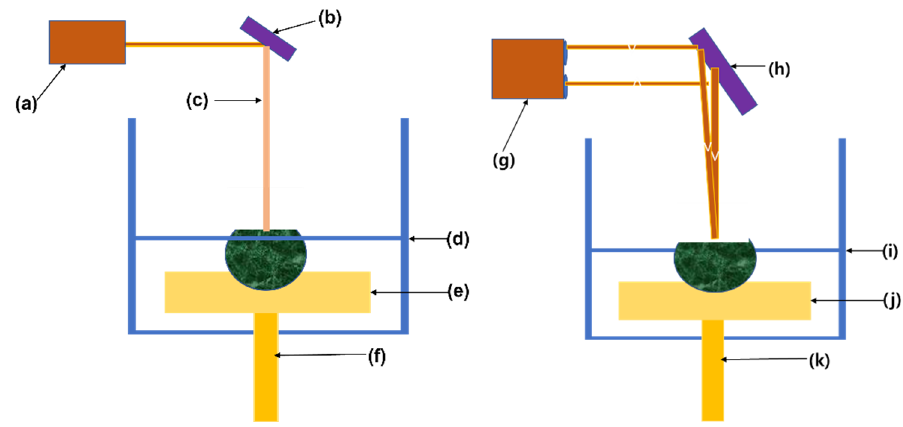
Figure 2. Scheme of stereolithography (SLA) and digital light processing (DLP). ( A ) SLA: (a) Laser source; (b) Scanning mirror; (c) Laser beam; (d) Liquid resin surface; (e) Platform (f) Piston, and ( B ) DLP: (g) Projector; (h) Scanning mirror; (i) Liquid resin surface; (j) Platform; (k) Piston.